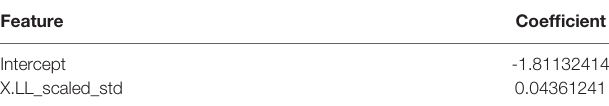
TABLE 3 | Radiomics feature.